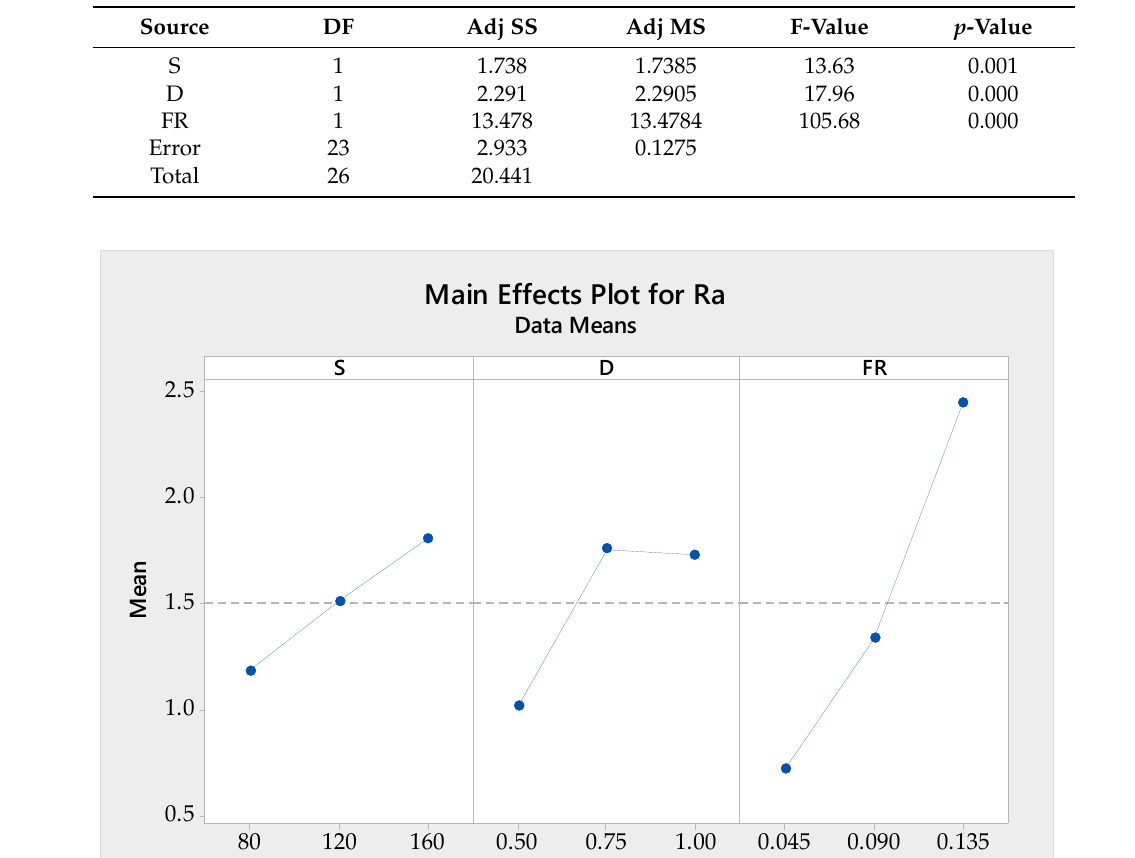
Table 4. ANOVA analysis results for parameter Ra using conventional cutting edge.